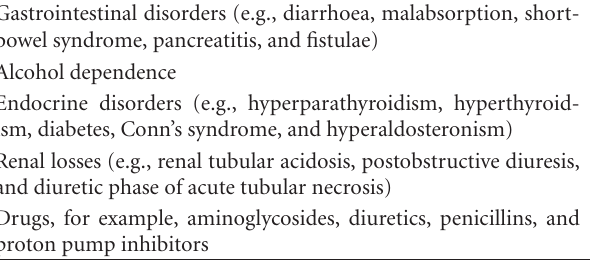
Table 2: Clinical manifestations of